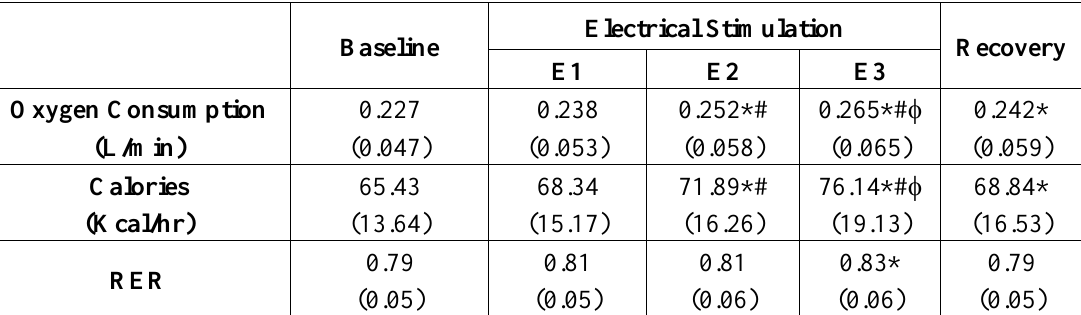
Table 2. The mean (standard deviation) for oxygen consumption, total calories, and RER during baseline, NMES at different levels of intensities, and recovery.